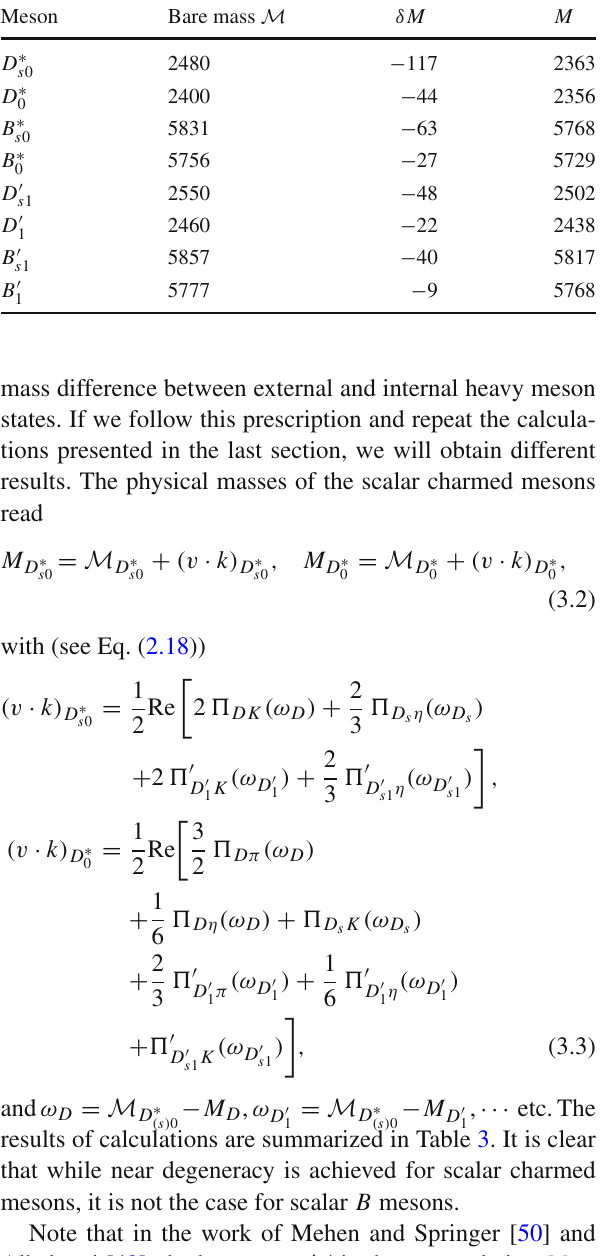
Table 3 Same as Table 2 except that the propagator i /( 2 v · k ) is used for all heavy meson states and v · k is set to be zero inside the loop integral